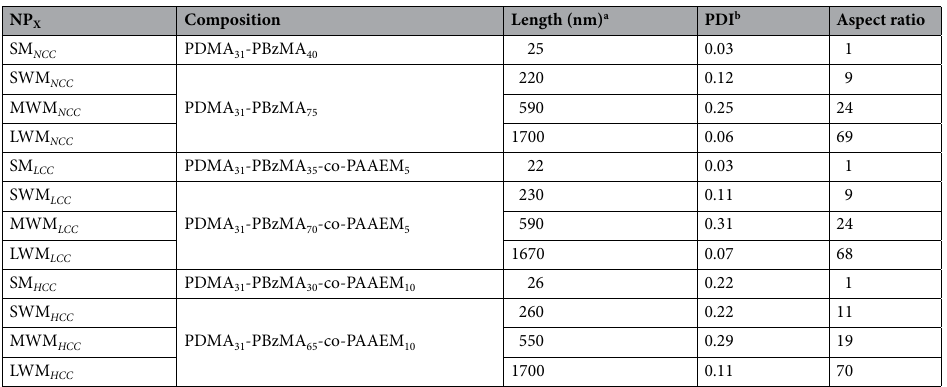
Table 1. Characterization of the nanoparticles prepared. X represents the crosslinking density of the micelle’s core. NCC = No core crosslinking (crosslinkable monomer = 0 mol%), LCC = low core crosslinking (crosslinkable monomers = 6.7 mol%), HCC = high core crosslinking (crosslinkable monomer = 13 mol%). a Calculated from the log-normal distribution of the size measured by TEM for N > 75. b Calculated from the log-normal distribution of the size measured by TEM for N > 75 as PDI = (σ/μ) 2 with σ the standard deviation of the distribution and μ the mean of the